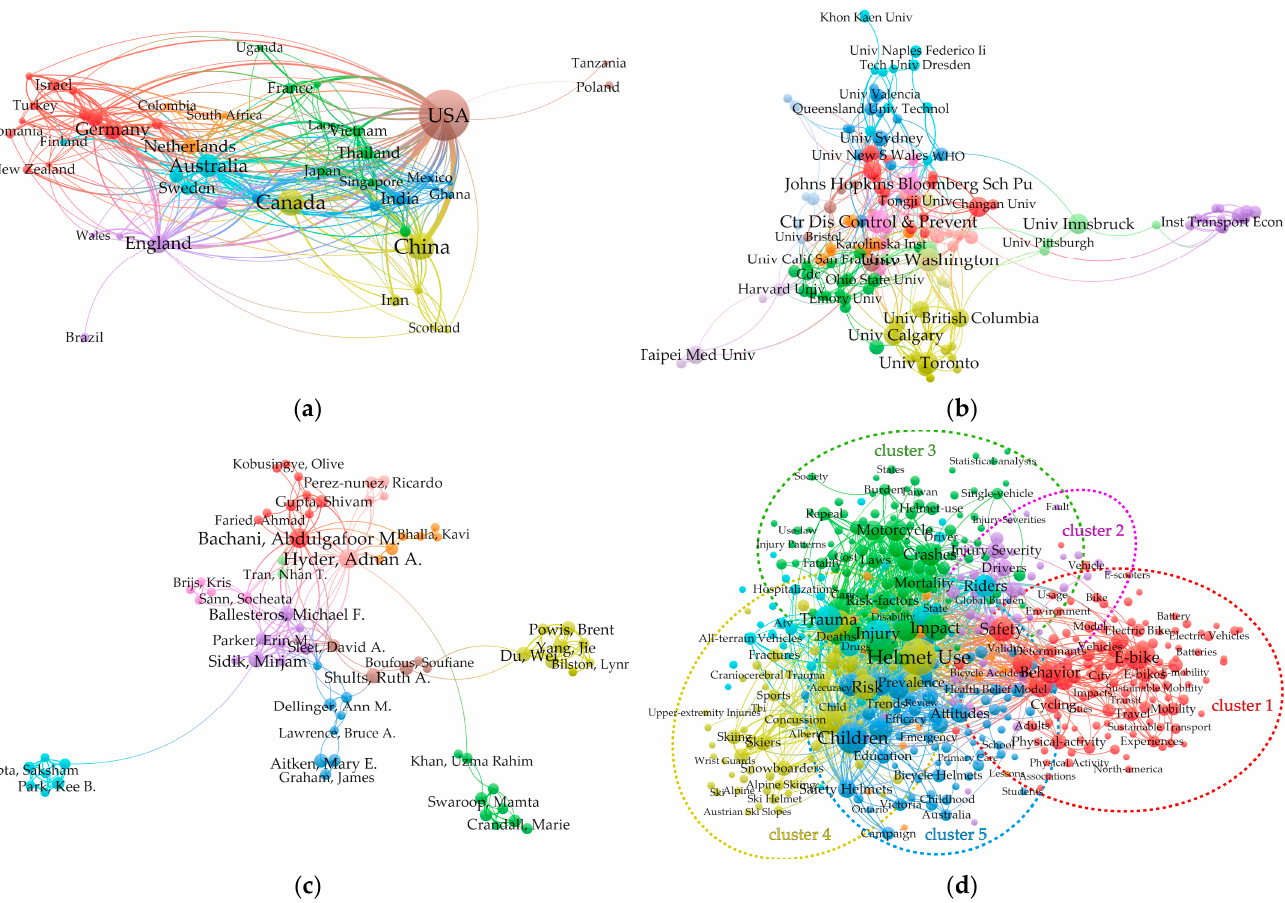
Figure 2. C ollaborative networks analysis for helmet studies. ( a ) Collaborative networks between countries, ( b ) collaborative networks between research organizations, ( c ) co-authorship network, ( d ) keyword co-occurrence network.